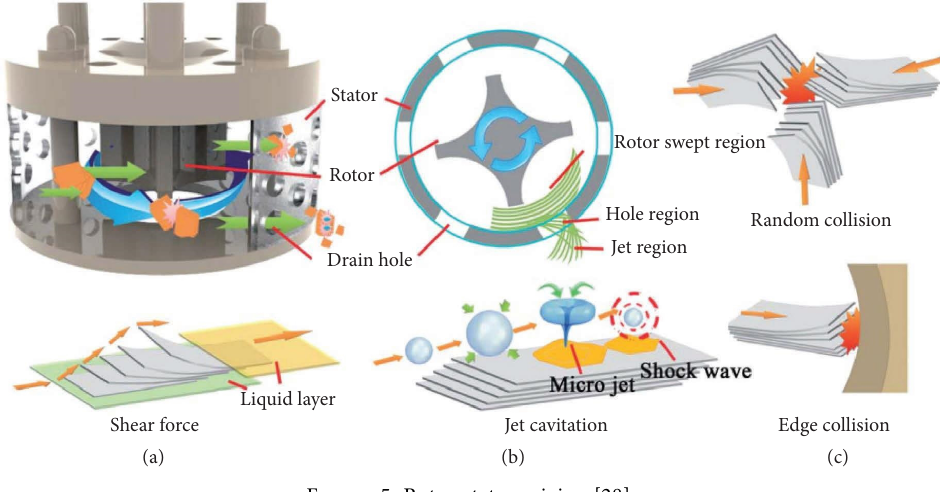
Figure 5: Rotor-stator mixing [28].